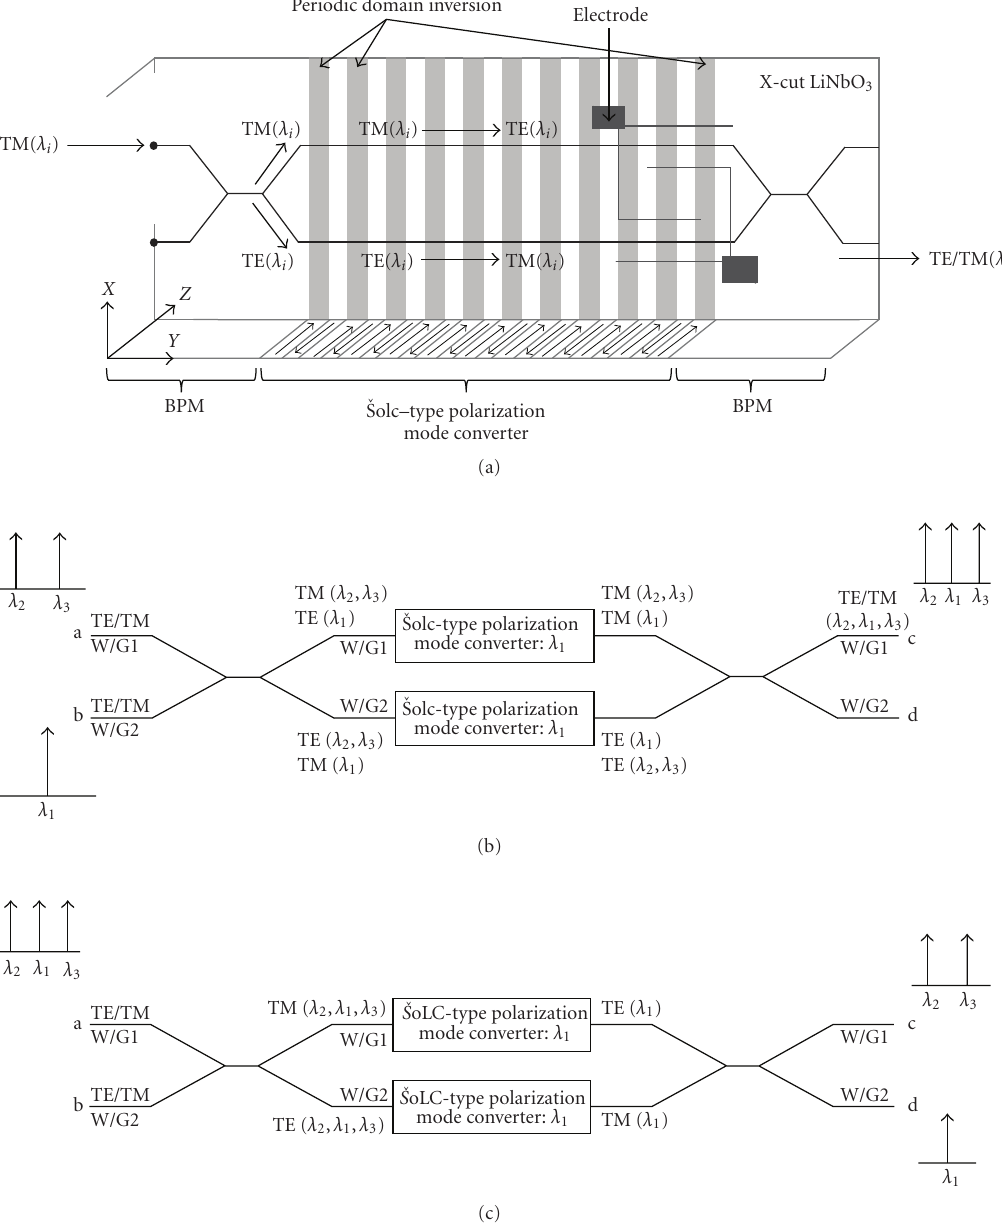
a particular wavelength channel to pass, is widely needed in wavelength-division multiplexing system. Recently, a flat-top band-pass ˇSolc-type wavelength filter in PPLN waveguide has been successfully proposed [9,